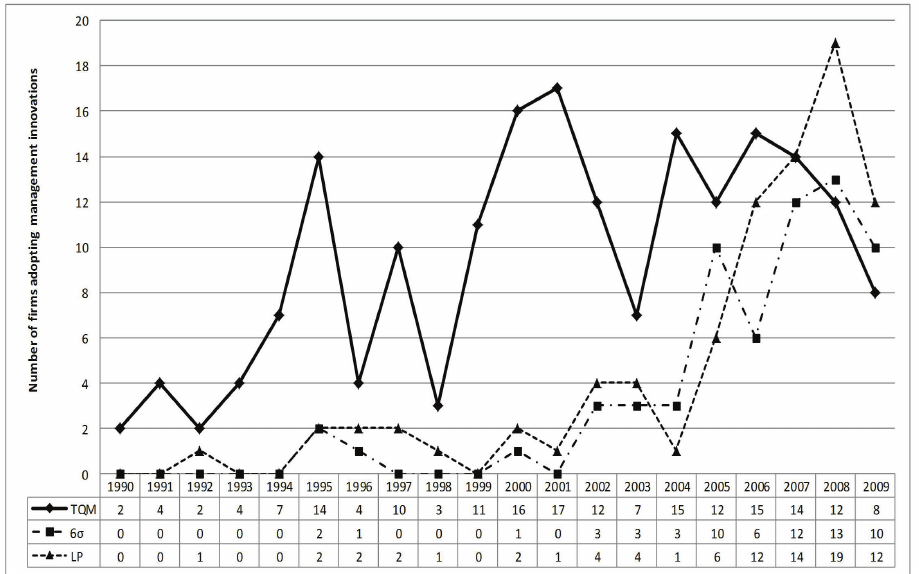
Fig. 2. Number of firms adopting TQM, 6σ and LP in Turkey,